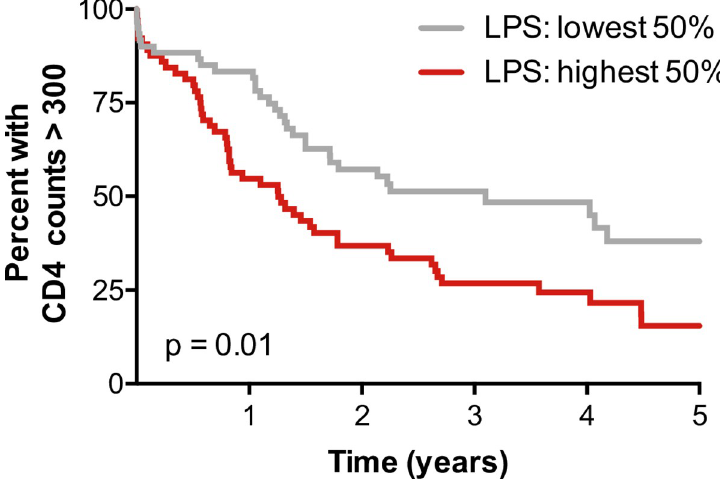
Fig 4. Circulating LPS levels measured during acute infection are associated with longitudinal CD4+ T cell decline. A Kaplan-Meier survival analysis comparing CD4+ T cell decline between individuals with LPS levels above or below the median for the cohort (n = 124). Thirteen individuals with CD4-protective HLA class I alleles were contained in the > 50% LPS group, and 21 in the < 50% LPS group. Statistics were generated from the log-rank